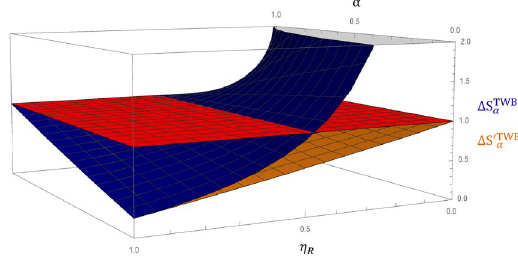
Figure 6. Uncertainty on α , normalized to the single mode coherent case ( 〈 〉 U input state and the two different estimators presented in the text ( S α in Eq. (1), blue surface, and S ′ α in Eq. (13), orange surface) in function of the losses on the reference path, η R , and α . It turns out that for η R close to one ~ S S TWB Δ Δ ′ α α this